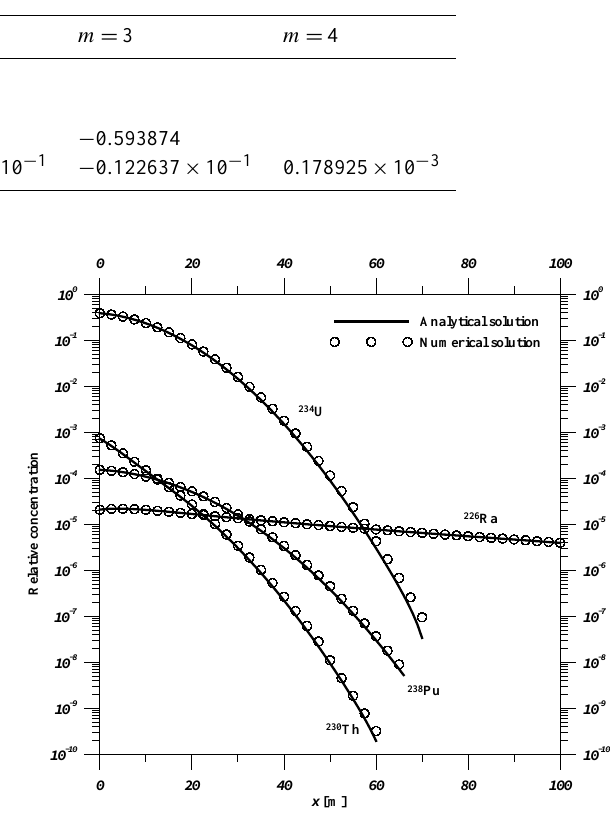
Figure 4. Comparison of spatial concentration profiles of four species along the transverse direction ( = 25m) at t = 1000years obtained from derived analytical solutions and numerical solutions for convergence test example 1 of four-member radionuclide decay chain 238 Pu → 234 U → 230 Th → 226 Ra.